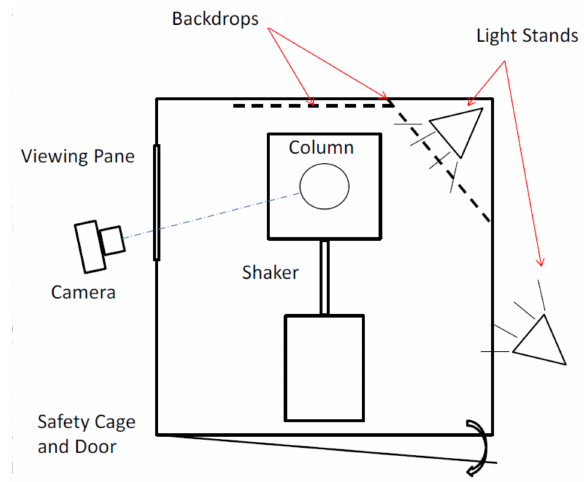
Figure 2. Schematic of camera and lighting configuration for flow